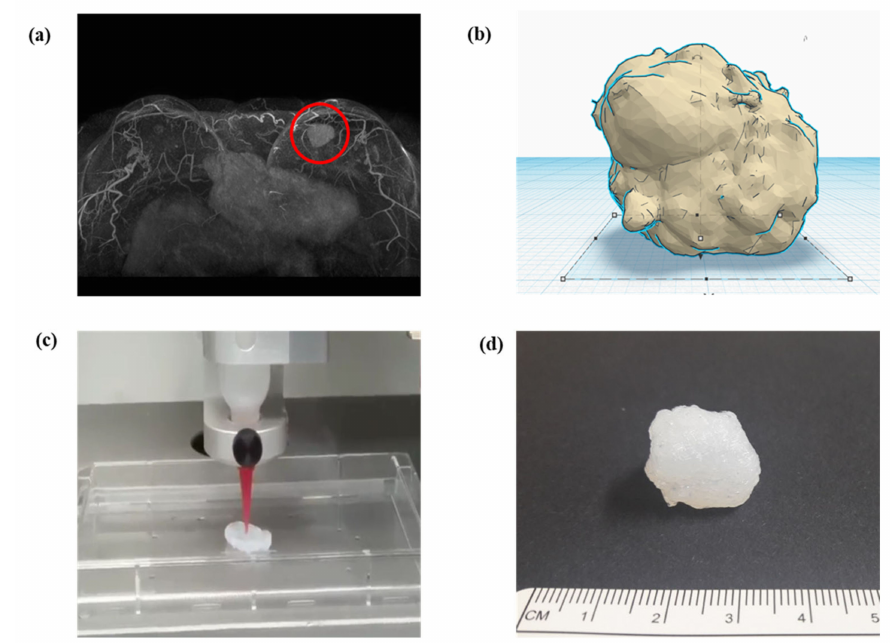
Figure 3. Schematic of converting a structure to ( a ) a 3D model through software and the final printout: a magnetic resonance imaging converted to stereolithography file, ( b ) modification in 3D model of stereolithography, ( c ) G-code generation in slicing, which is then delivered to a 3D printer, and( d ) final printout after